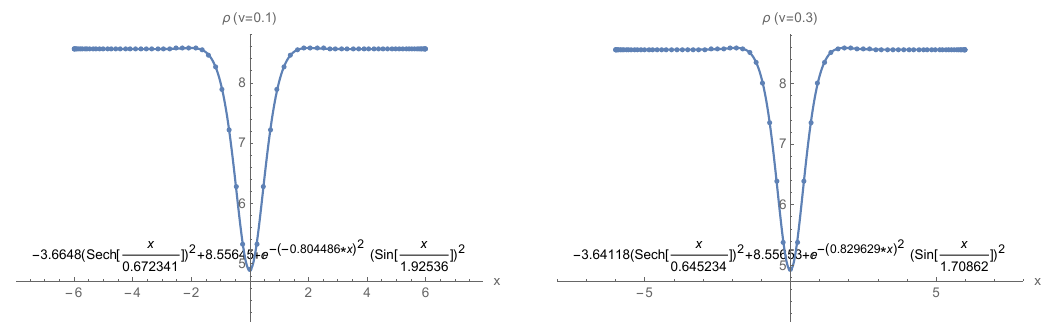
Figure 19 . The (cid:12)tting results, at (cid:22) = 5 : 5, for the density with di(cid:11)erent speeds under the standard quantization.